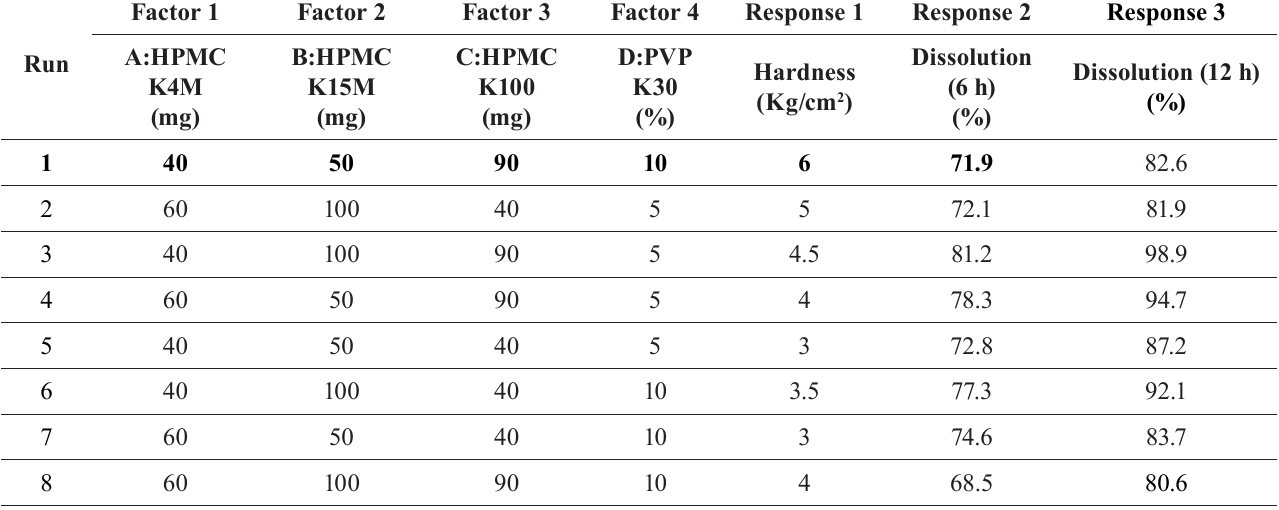
TABLE II - Screening run batches suggested by reduced factorial design Factor Run